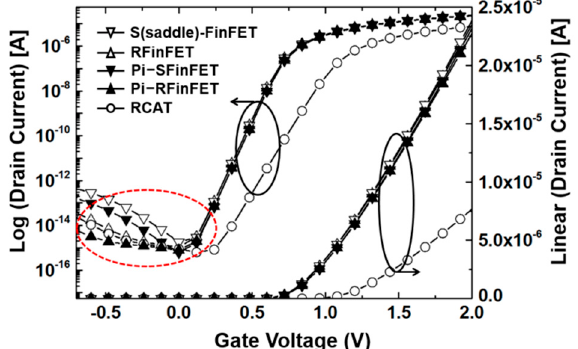
Figure 2. I DS -V GS characteristic for S-FinFET, RFinFET, Pi-FinFETs, and RCAT at V DS = 1.5 V. Figure 2. I DS ‐ V GS characteristic for S ‐ FinFET, RFinFET, Pi ‐ FinFETs, and RCAT at V DS = 1.5 V. I off(S ‐ FinFET) I off(S-FinFET) = 1.62 × 10 − 13 A, I off(RFinFET) = 7.80 × 10 − 15 A, I off.Pi-SFinFET = 5.19 × 10 − 14 A, I off.RFinFET = 1.62 × 10 − 13 A, I off(RFinFET) = 7.80 × 10 − 15 A, I off.Pi ‐ SFinFET = 5.19 × 10 − 14 A, I off.RFinFET = 1.92 × 10 − 15 A at V GS of = 1.92 × 10 − 15 A at V GS of − 0.5 − 0.5 V.